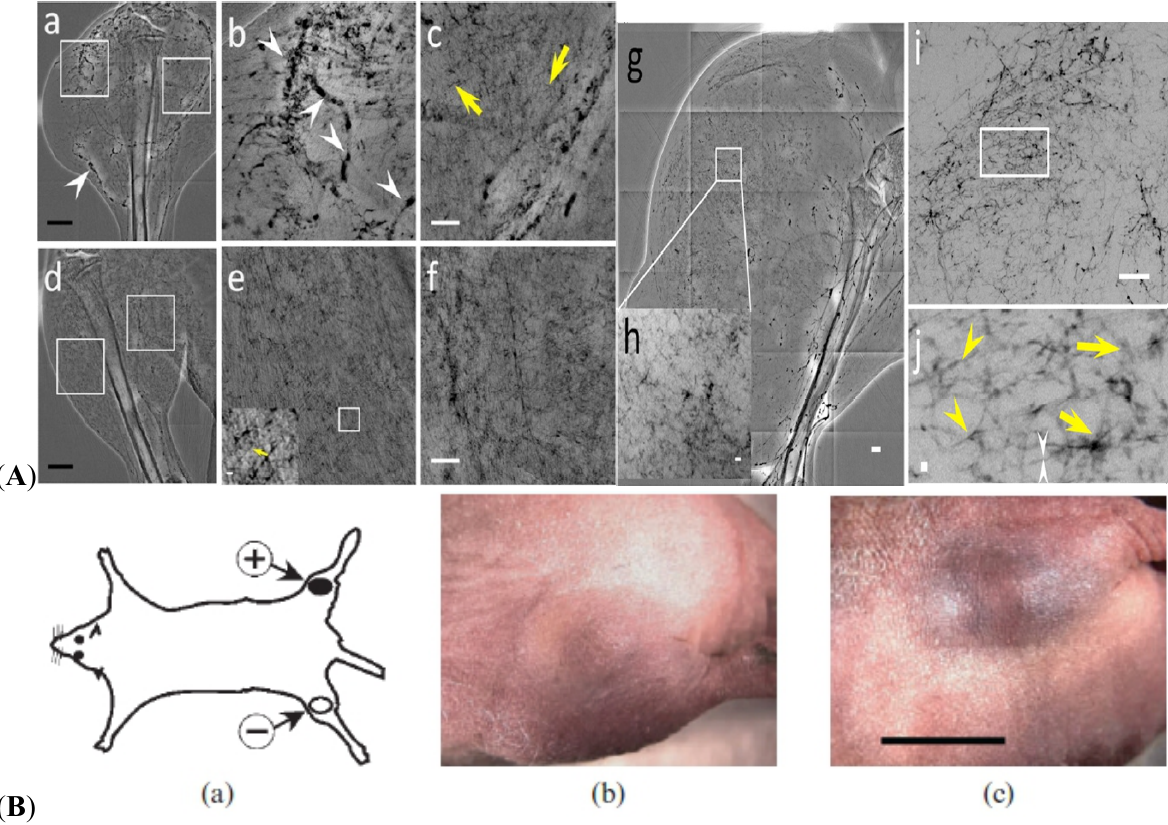
Figure 9. ( A ) X-ray micrographs of the microvasculature of normal tissue and tumors at different time period after the tumor inoculation with AuNPs and heparin injection. Micro-radiology is implemented with unmonochromated (white) synchrotron X-rays. ( a ) In vivo image of the lateral thigh, 7 days after inoculation. ( b and c ) Magnified images of the left square in ( a ), near the tumor area, and the right square, which correspond to normal tissue area (medial thigh). The arrowheads in ( a ) and ( b ) mark vessels showing AuNP agglomeration. The yellow arrows mark vessels of < 6 μ m diameter. ( d ) In vivo image of the normal lateral thigh. ( e , f ) Magnified images of the left and right squares in ( d ). The inset in the lower left corner of (e) is also magnified image. The yellow arrow marks a < 6 μ m diameter vessel. ( g ) In vivo image of the lateral thigh, 16 days after inoculation. ( h ) Magnified image of the square in ( g ). ( i ) Image of a 1 mm thick tissue removed from the thigh shown in ( g ). ( j ) Magnified image of the rectangle in ( i ). The yellow arrowheads mark abnormal vessels. The white arrowheads mark a vessel with ~2 μ m diameter. The yellow arrows show areas with diffusion of AuNPs. Scale bar for ( a ), ( d ) and ( g ): 2 mm. Scale bar for ( b ), ( c ), ( e ), ( f ), and ( i ): 500 μ m. Scale bar for inset of ( e ) and ( h ): 50 μ m. Scale bar for ( j ): 10 μ m. [58]. ( a ) Mouse model with two implanted tumors: Her2+ in one thigh and Her2– in the contralateral thigh. ( b , c ) The same mouse with a Her2– tumor ( b ) and Her2+ tumor ( c ) 20 h after intravenous injection of 15 nm AuNP–Herceptin (0.45 g Au kg − 1 body weight). Tumor volumes (by caliper measurements) are nearly identical, but a distinction can be seen owing to the targeted Au localization. Bar = 55 mm [66]. Adapted by permission from BioMed Central and The British Institute of